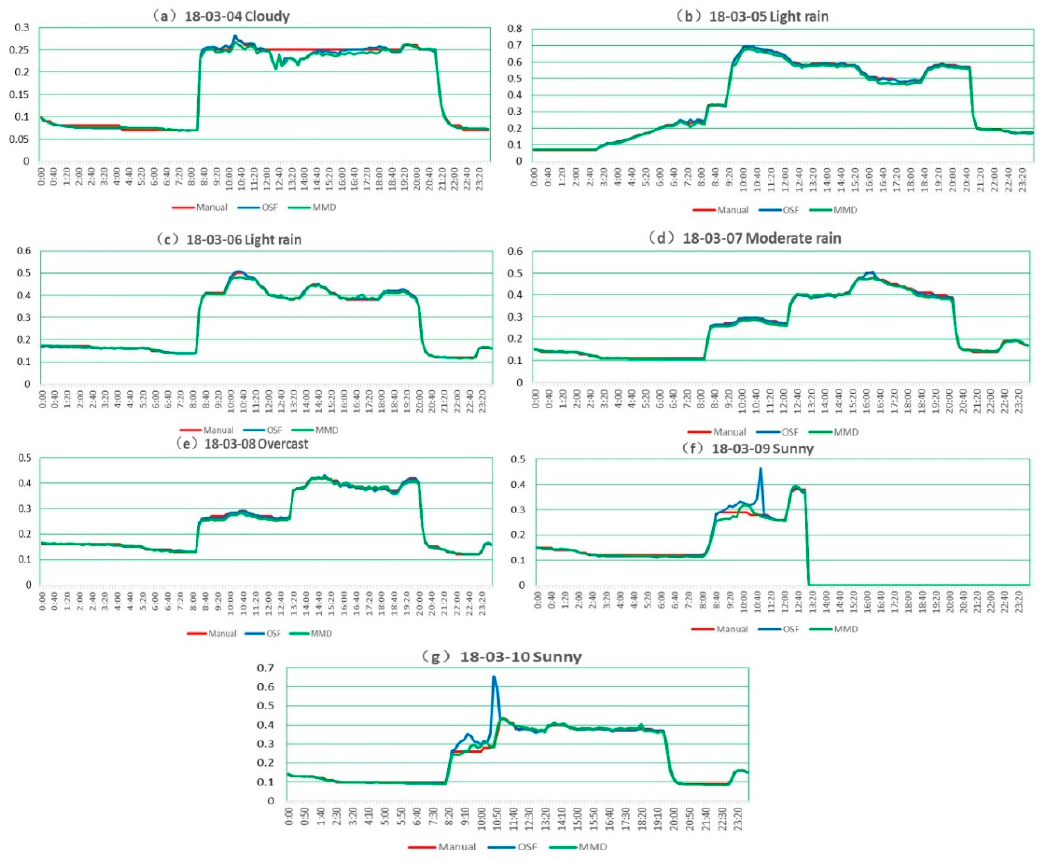
Figure 14. Time series of daily water-level measurements: ( a ) cloudy (18–03–04); ( b ) light rain (18– 03–05); ( c ) light rain (18–03–06); ( d ) moderate rain (18–03–07); ( e ) overcast (18–03–08); ( f ) sunny (18– 03–09); ( g ) sunny (18–03–10).